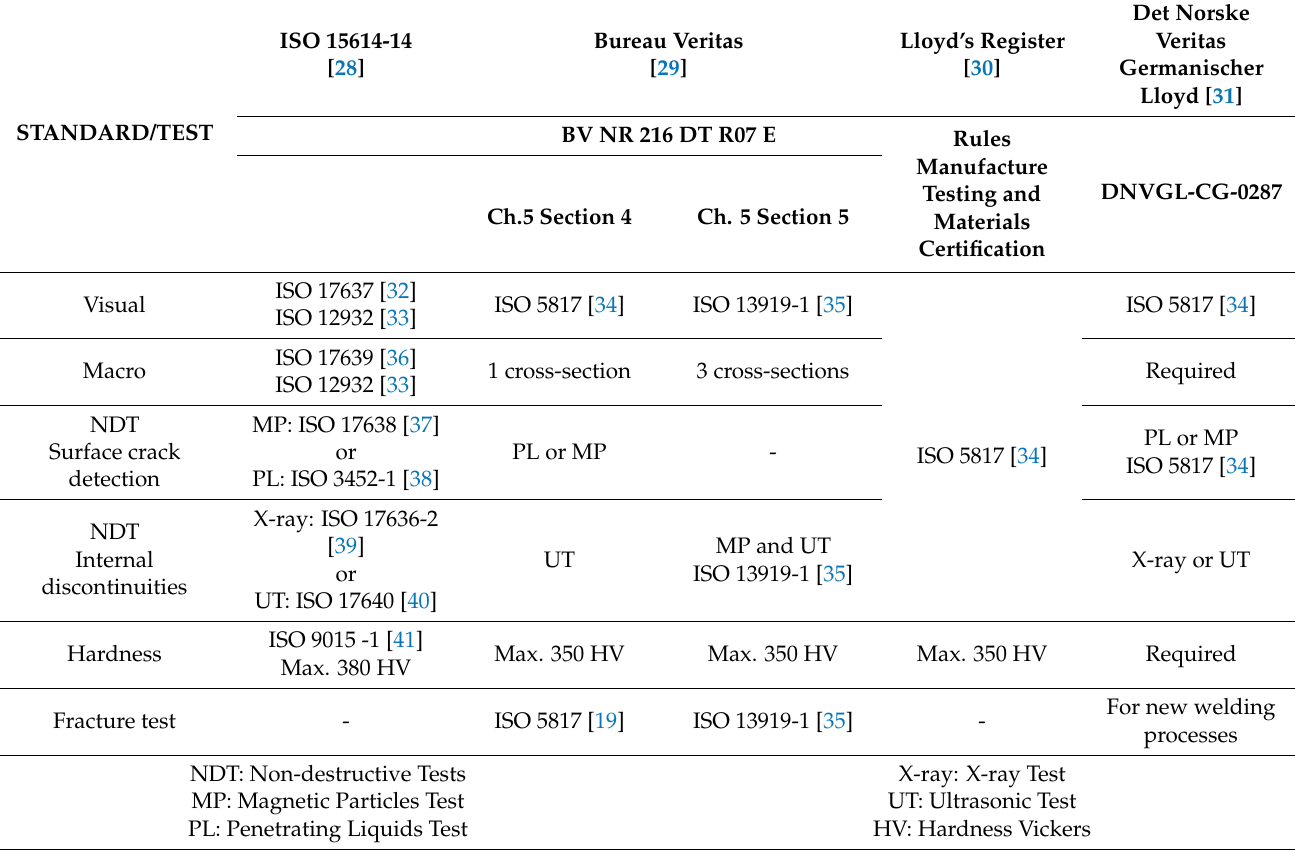
Table 1. Summary of standards and tests for the evaluation of HLAW T-joints according to shipbuilding regulation.